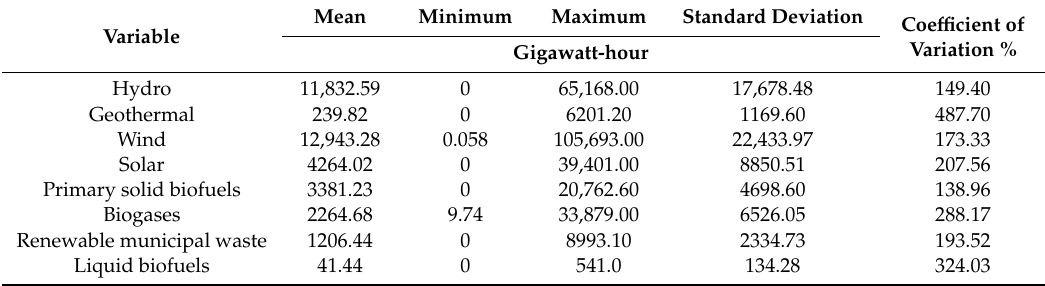
Table 5. Selected statistical parameters of variables determining the volume of energy production from selected renewable energy sources in the EU countries in 2017 (own study).